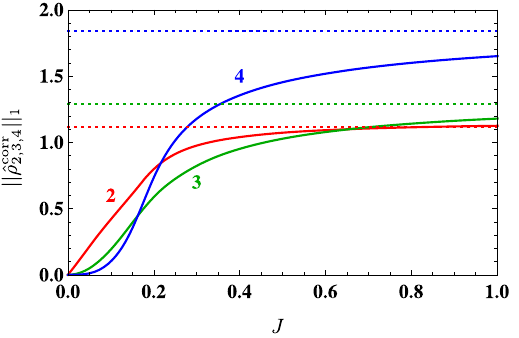
Figure 4. Norms of correlated reduced density operators for two ρ ˆ 2corr (red), three ρ ˆ 3corr (green), and four ρ ˆ 4corr (blue) neighboring sites in the Bose-Hubbard model with 12 particles in 12 lattices sites. The horizontal dotted lines represent the limit of the ideal Bose gas ( J → ∞ ). The hierarchy of correlations (first two-point, later three- point and even later four-point correlations) is present for small J . The four-point correlations overtake the three-point correlations well before the critical point (here ≈ . J 0 3 crit